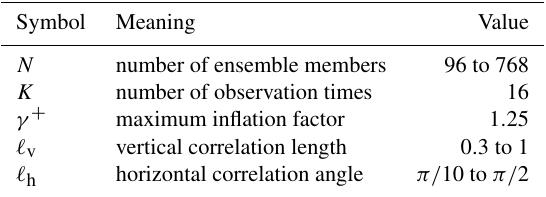
Table 3. Notations and range of values tested for data